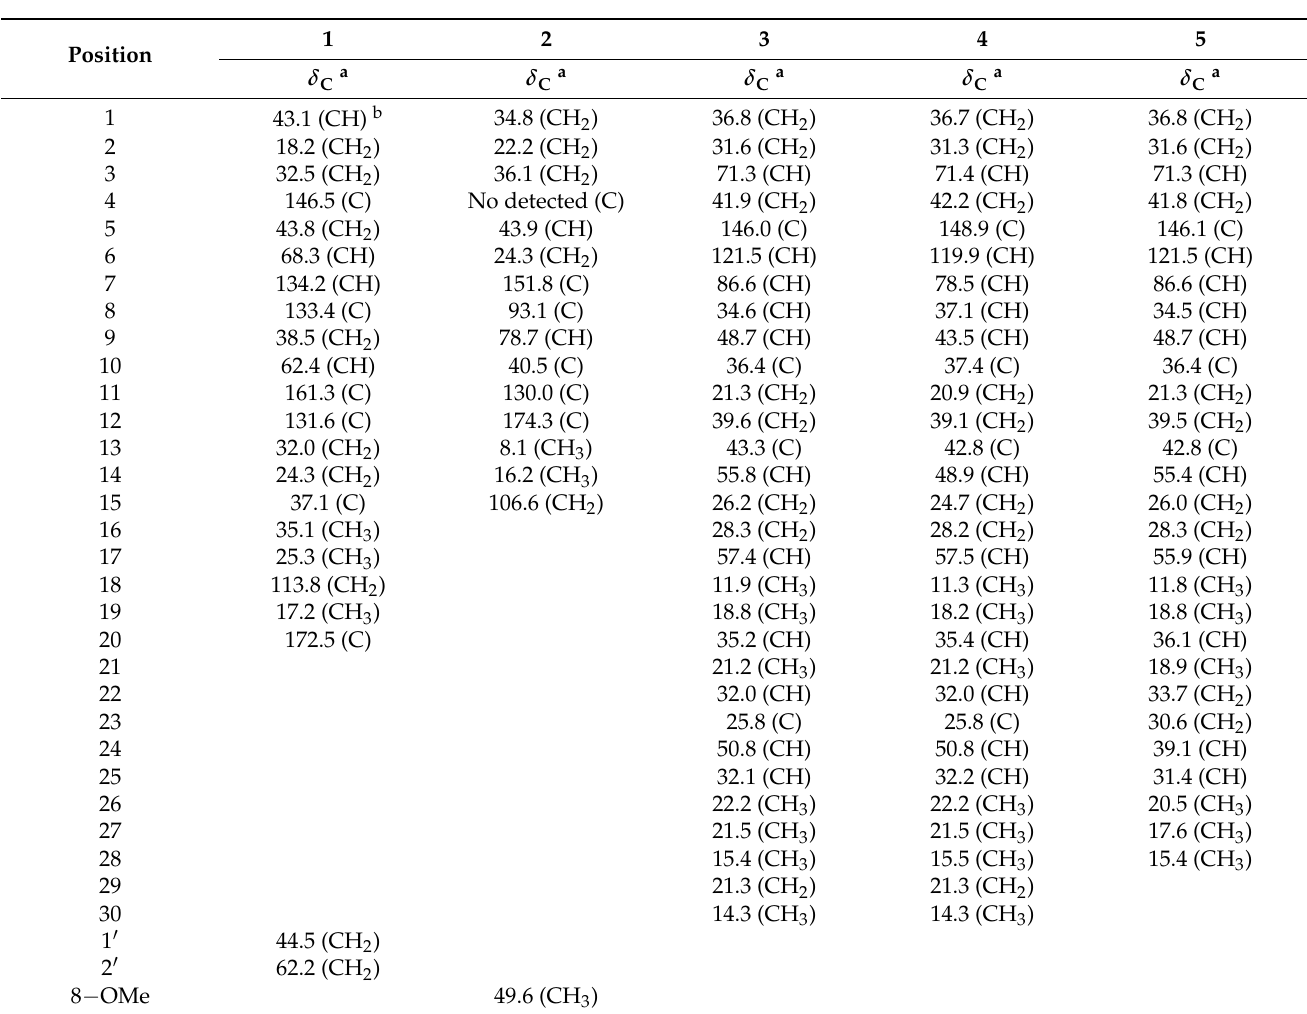
Table 2. 13 C NMR spectroscopic data of compounds 1 – 5